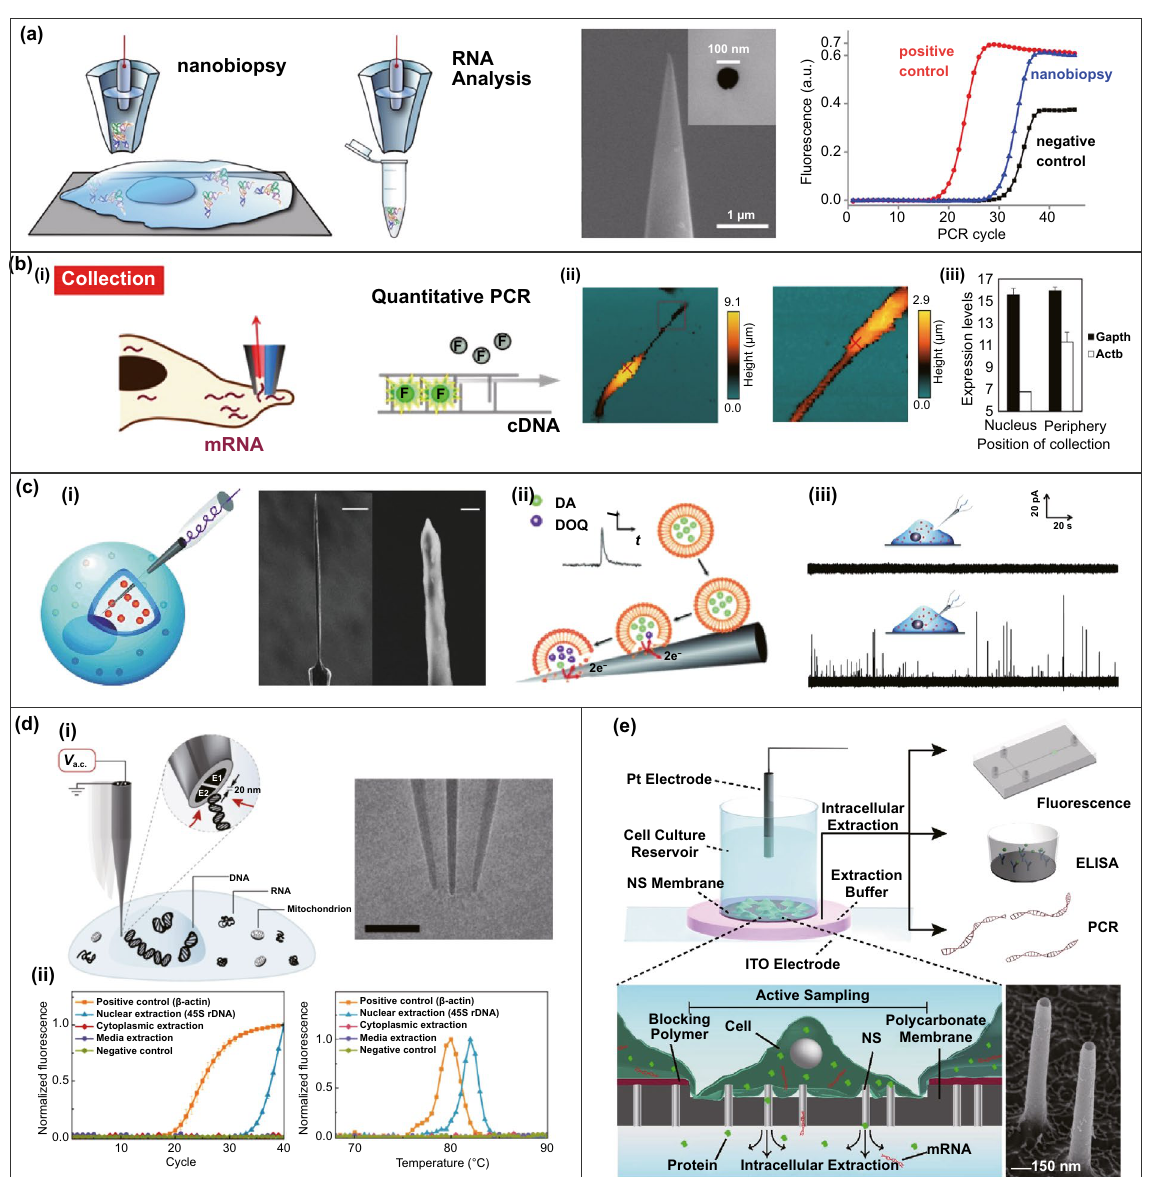
Fig. 6 a A schematic of the nanobiopsy examinated by RNA analysis and an SEM image of the nanomicrotubule tip [126]. b (i) Schematic dia‑ gram of the electrochemical injector moving to the target location in a semi‑automatic manner to collect mRNA‑containing cytosol and detect it by qPCR. (ii) SICM images of the collection process. (iii) Statistical analysis of mRNA expression levels at each site [127]. c (i) Schematic illus‑ tration (small orange circles represent vesicles), and view of a nanotip conical carbon‑fiber microelectrode. (iii) Mechanism of the adsorption and opening of vesicles on the in situ electrode. (iv) Amperometric traces for a nanotip conical carbon‑fiber microelectrode pushed [128]. d (i) Schematic diagram of applying AC voltage to nanotweezers for targeted capture of molecules in solution or within cells, and TEM image of the DEP nanotweezer. (ii) Average qPCR amplification and typical melting curves of extracted DNA [129]. e The nondestructive nanopipette intra‑ cellular sampling system allowed contents to be extracted by electroporation from cells cultured on 150 nm polymer membranes and analyzed by fluorescence, ELISA or qPCR. SEM images of the NS (bottom right) [130]. Reproduced with permission from Refs. [126–130], copyright (2014) American Chemical Society Publishing Group (2016) American Chemical Society Publishing Group (2015) Wiley–VCH Publishing Group (2019) Nature Publishing Group and (2017) Proceedings of the National Academy of Sciences Publishing